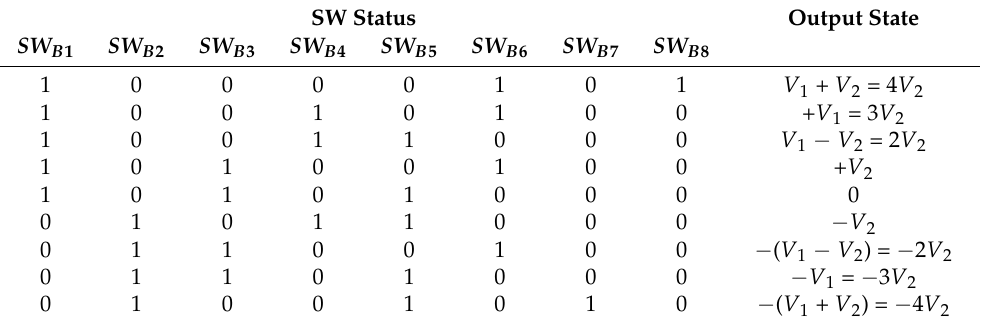
Figure 1. Main circuit of the nine-level active power filter. Table 1. Output state of a new